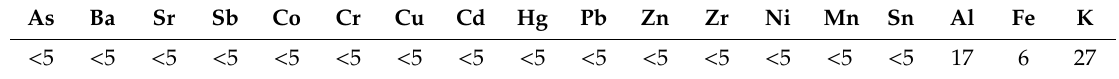
Table 7. Leach test results (mg / kg).